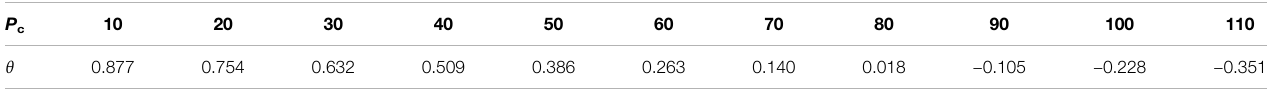
TABLE 3 | The proportion of government giving subsidies to owner for investment of carbon-emission reduction under different carbon prices.